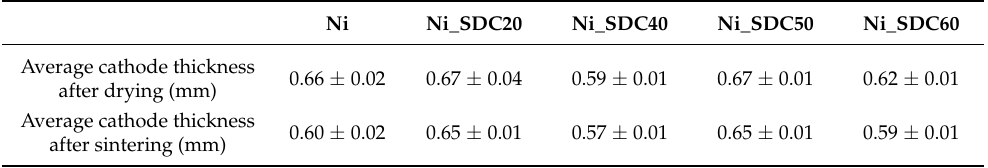
Table 1. Characterization of cathode thickness before and after the sintering process.